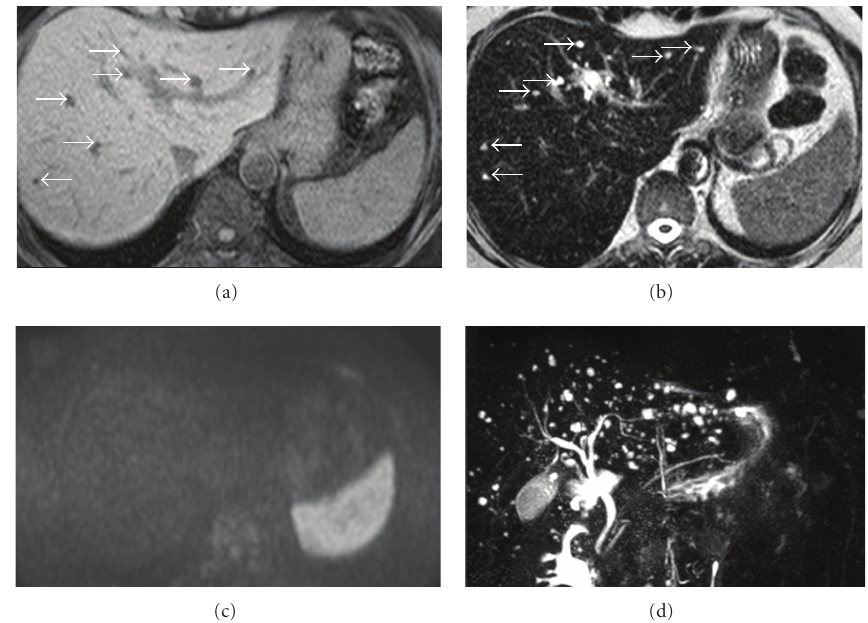
Figure 3: On T1-weighted image of the liver (a), multiple, small, hypointense nodular lesions with slightly irregular contours (white arrows) are demonstrated, which are hyperintense (b) (white arrows) on T2-weighted image. Di ff usion-weighted image (c) reveals no restriction of di ff usion in the liver lesions. MRCP (d) depicts an abundant number of hyperintense small lesions allover the liver which show no association with the biliary system. The widths and contours of intrahepatic and extrahepatic bile ducts and pancreatic canal are